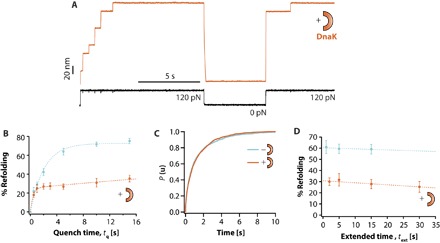
DnaK(ADP) hinders protein folding by binding to the intermediate collapsed states.(A) Refolding of ubiquitin is severely compromised in the presence of 5 μM DnaK(ADP). (B) The associated refolding kinetics (orange symbols; tq = 0.5 s, n = 30 individual trajectories; tq = 1 s, n = 46; tq = 2 s, n = 43; tq = 5 s, n = 51; tq = 10 s, n = 27; tq = 15 s, n = 31) plateaus at a low refolding yield of ~30% and cannot be captured by a single exponential. Instead, a calculated function obtained from a multiparametric fit (see Materials and Methods and figs. S11 and S12) reproduces the experimental data with high accuracy (orange fit). (C) The kinetics of ubiquitin unfolding at 120 pN (ku = 0.93 ± 0.06 s−1, n = 195 unfolding trajectories) is not affected upon addition of DnaK (ku = 0.92 ± 0.05 s−1, n = 194 unfolding trajectories), hence suggesting that DnaK does not bind the native state of ubiquitin. (D) Similarly, the refolding yield is not significantly modified with text (text = 2 s, n = 49; text = 5 s, n = 21; text = 15 s, n = 22; text = 30 s, n = 26). Combined, these observations suggest that DnaK binds the intermediate, collapsed conformations.